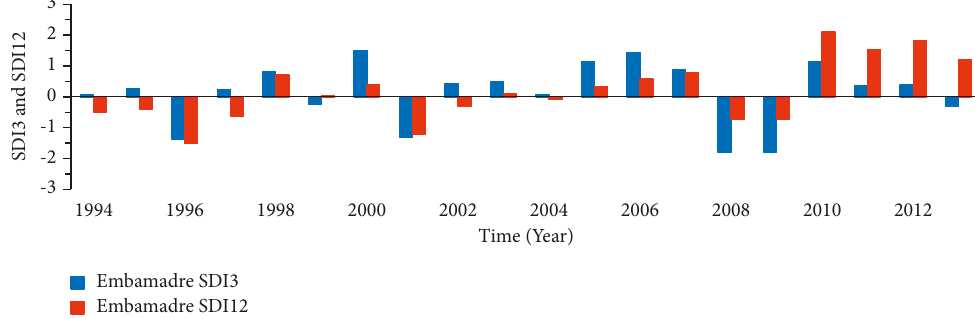
Figure 11: Temporal variation in seasonal (SDI3) and annual (SDI12) for the Tekeze river basin. Table 5: Recapitulation of hydrological drought characteristics.